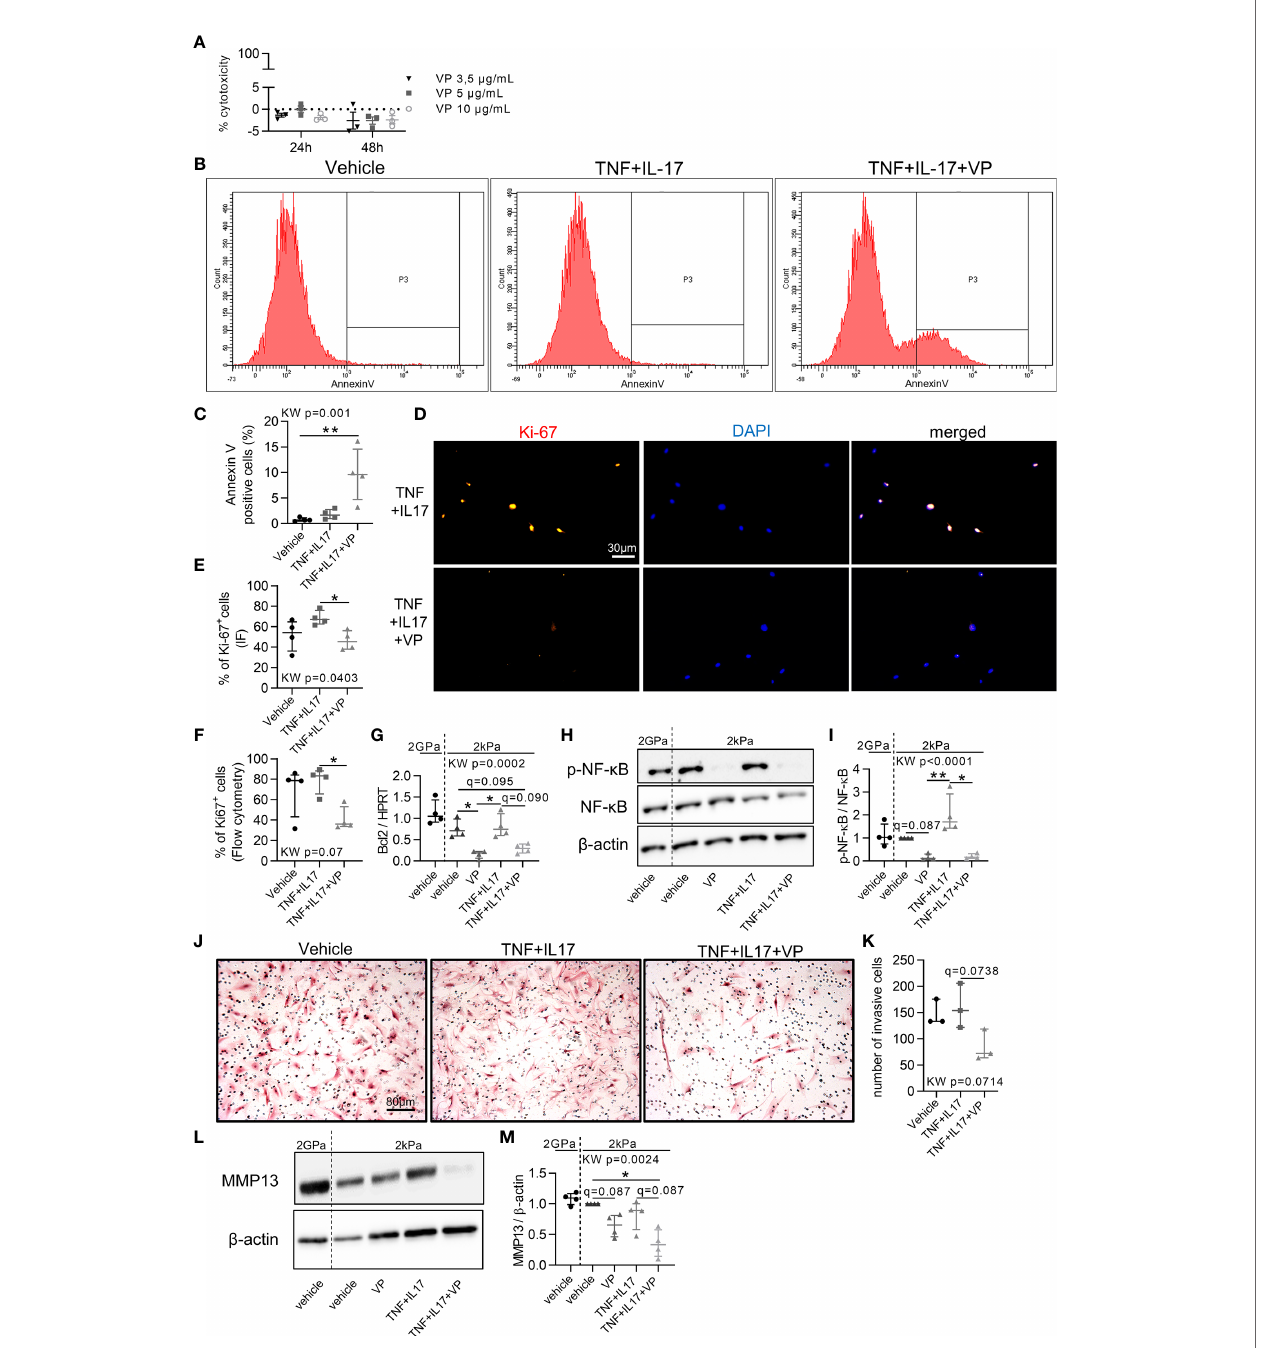
FIGURE 3 | Blocking the aggressive phenotype of RA FLS by YAP/TAZ inhibition. RA FLS (n=4 patients, except when speci fi ed) were cultured on soft (2 kPa) or classic stiff (2 GPa) substrate and treated with VP, TNF, IL-17 for 48 hours. (A) Lactate dehydrogenase cytotoxicity assay for RA FLS (n=1 patient) in triplicate. Positive control was set at 100%. (B, C) Flow cytometry representative histograms (B) showing the number of annexin V negative (left) and positive cells (right) with corresponding quanti fi cation (C) . (D, E) Representative epi fl uorescence images (D) of Ki-67 (orange), DAPI (blue), and merged with corresponding quanti fi cation (E) and fl ow cytometry quanti fi cation (F) . (G) RT-qPCR quanti fi cation of Bcl2 expression normalized by HPRT expression. (H, L) Representative western blot results of phospho(p)-NF- k B p65 (serine536: active form), total NF- k B p65, b -actin (H) ; and MMP-13 (L) with their quanti fi cation normalized by the 2kPa group for each patient and b -actin (I, M) . (J, K) Representative images of invasion transwell assay stained with hematoxylin and eosin (H&E) at x10 magni fi cation (J) with quanti fi cation (K) performed in duplicate for RA FLS (n=3 patients). Data were presented as individual values with median and interquartile range. For statistical analysis, please see Figure legend 2. VP, 10 µM (except other mention); TNF, 10 ng/ml; IL-17, 50 ng/ml; p, phospho; NF- k B, nuclear factor- k B; MMP, matrix